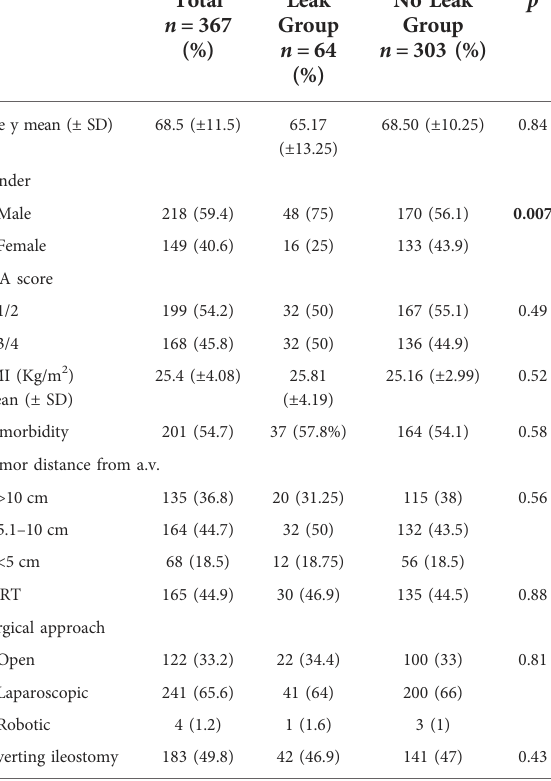
TABLE 1 Baseline patients ’ characteristics and perioperative features.